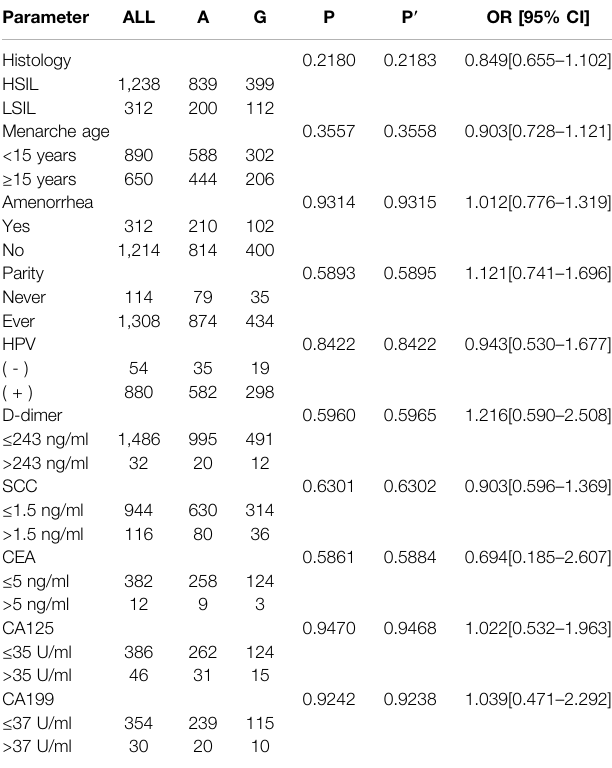
TABLE 10 | Comparison of allele distribution frequencies with clinical parameters in the SIL group.